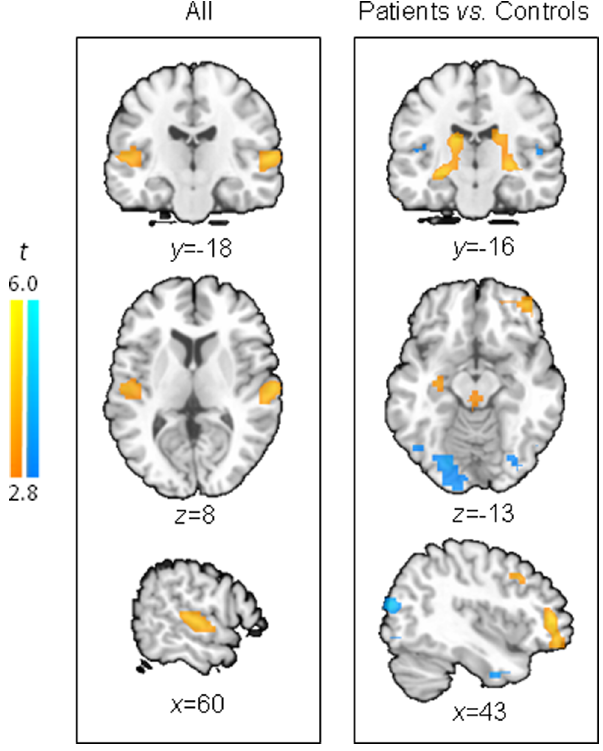
Figure 1. Group effects of auditory stimulation on brain metabolism (rGMR). Left panel : t maps show increased brain metabolism in the superior temporal cortex during the auditory stimulation condition relative to the resting condition in all participants (including patients and controls). Right panel : during auditory stimulation, patients showed increased metabolism in mesolimbic regions and decreased metabolism in fusiform gyrus compared to controls. Maps are thresholded at p=0.005 and 10 adjacent voxels. Orange colors represent a relative increase in metabolic activity; blue colors represent a relative decrease in metabolic